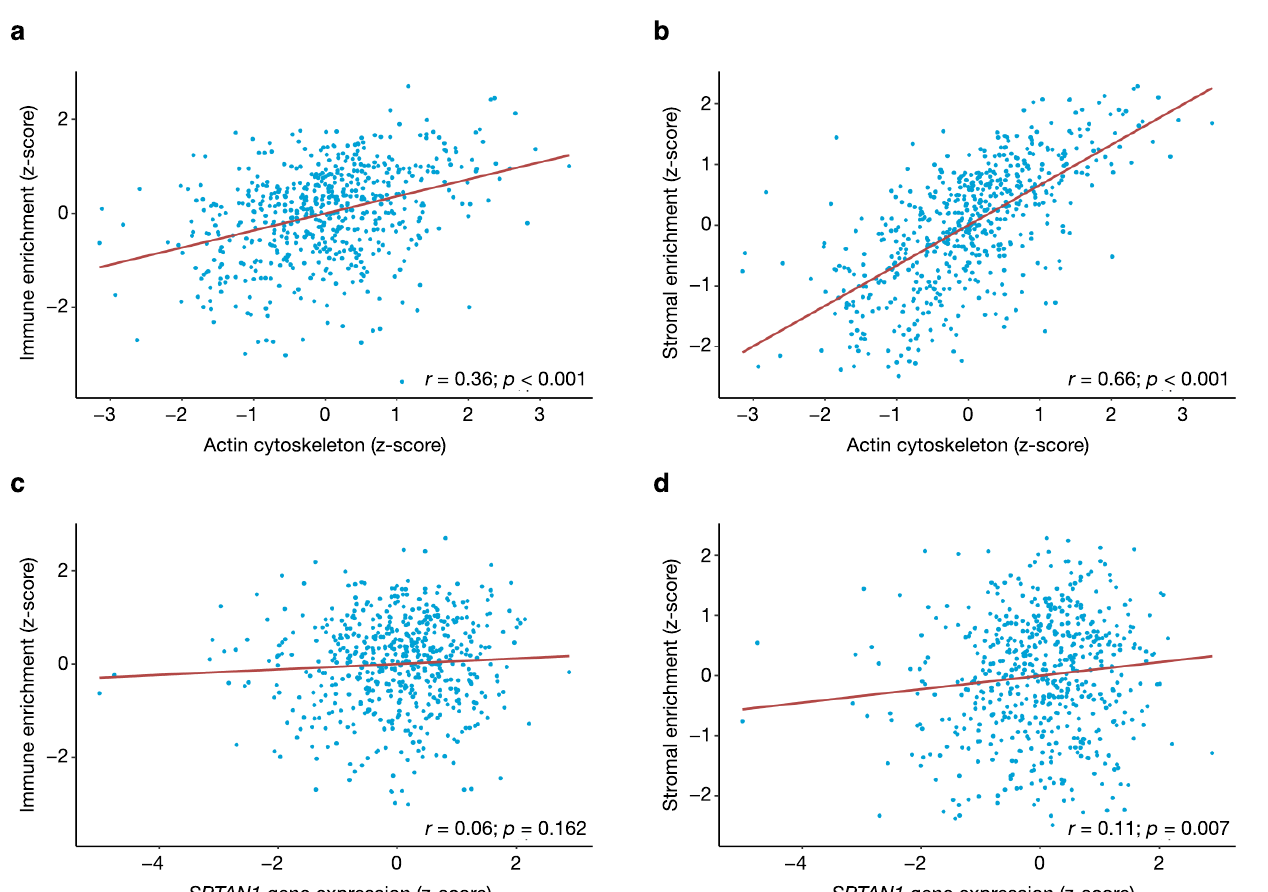
Figure 3. Tumour purity affects the expression of actin cytoskeletal genes but not SPTAN1 gene expression. Scatter plots showing the respective associations between actin cytoskeletal gene expression and ( a ) immune or ( b ) stromal infiltration, and between SPTAN1 gene expression and ( c ) immune or ( d ) stromal infiltration. The analysis is based on gene expression data from the TCGA cohort (573 patients). The GenePattern ssGSEA module was used to quantify actin cytoskeletal gene expression, and to compute immune and stromal enrichment scores. Pearson’s r coefficient was determined using the cor.test function in the standard R environment, and results with a p -value < 0.05 were considered statistically significant.